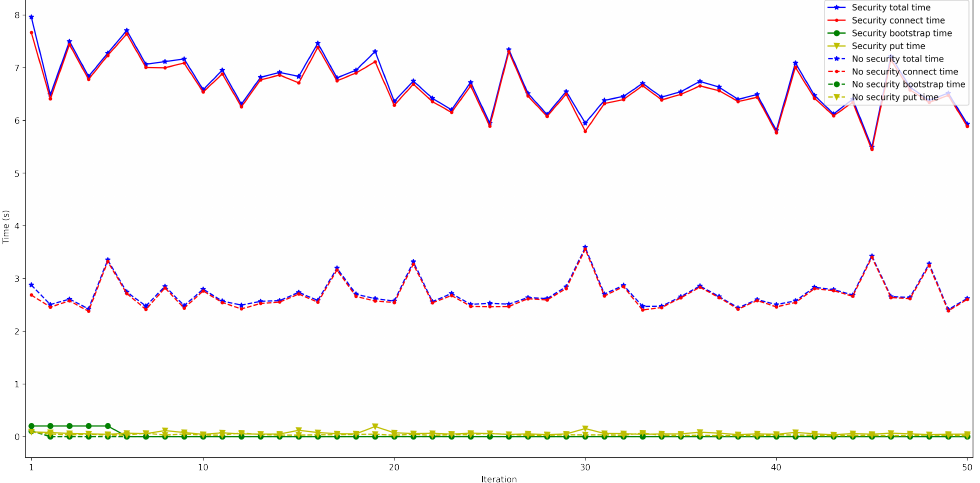
Figure 26. Latency when enabling/disabling TLS 1.3 for 600 peers connected to the bootstrap node.